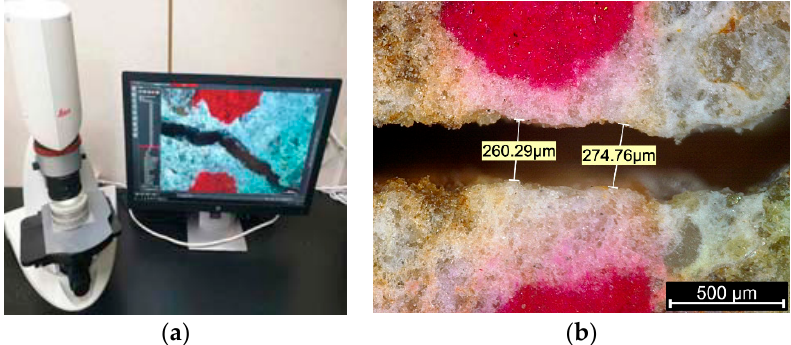
Figure 3. Measurement of crack width: ( a ) microscope measurement system, ( b ) crack width.